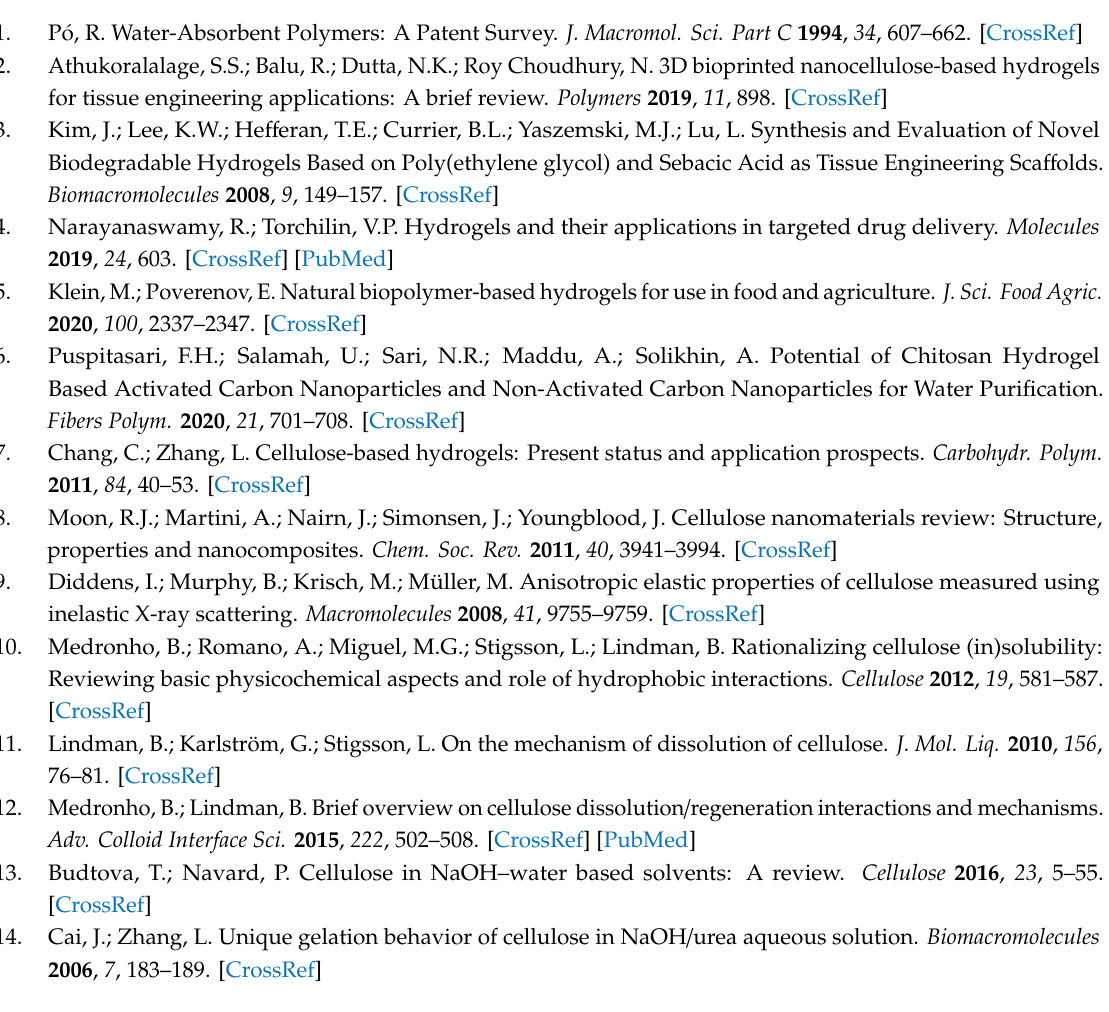
Figure S1: DSC thermogram of wax 1, recorded at a heating rate of 10 ◦ C / min; Figure S2: DSC thermogram of wax 1, recorded at a heating rate of 25 ◦ C / min; Figure S3: DSC thermogram of wax 1, recorded at a heating rate of 1 ◦ C / min; Figure S4: DSC thermogram of wax 2, recorded at a heating rate 10 ◦ C / min; Figure S5: DSC thermogram of wax 2, recorded at a heating rate 25 ◦ C / min; Figure S6: DSC thermogram of wax 2, recorded at a heating rate 1 ◦ C / min; Figure S7: DSC thermogram of wax 3, recorded at a heating rate 10 ◦ C / min; Figure S8: DSC thermogram of wax 3, recorded at a heating rate 25 ◦ C / min; Figure S9: DSC thermogram of wax 3, recorded at a heating rate 1 ◦ C / min. Table S1: Melting behaviour of wax 1, 2 and 3 at various cooling and heating